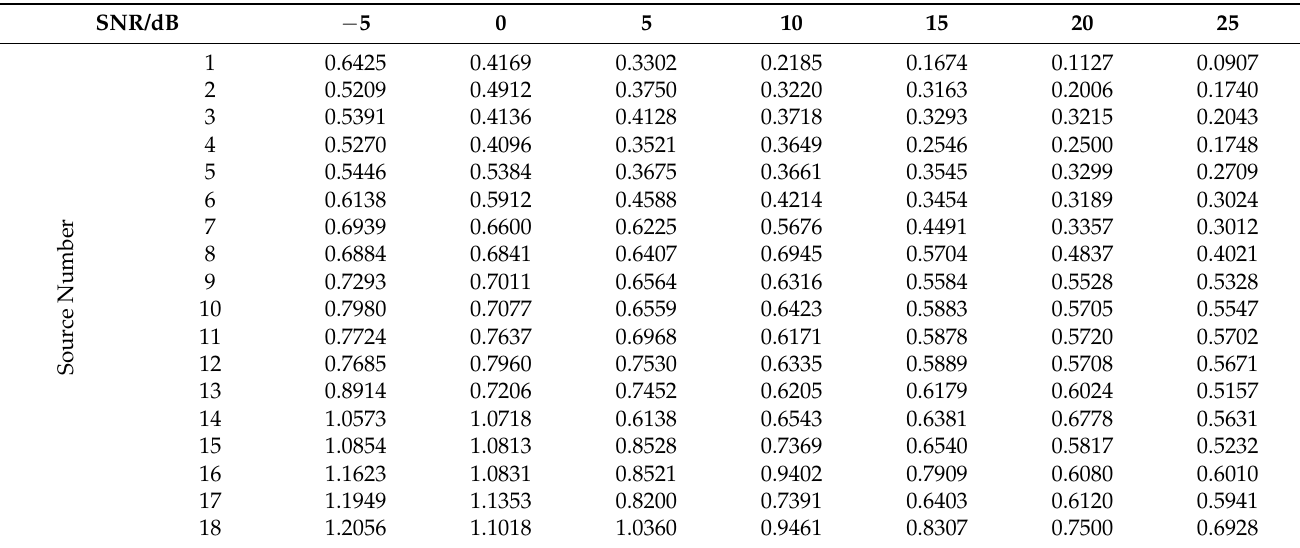
Table 6. RMSE of DOA estimation for ULA at different